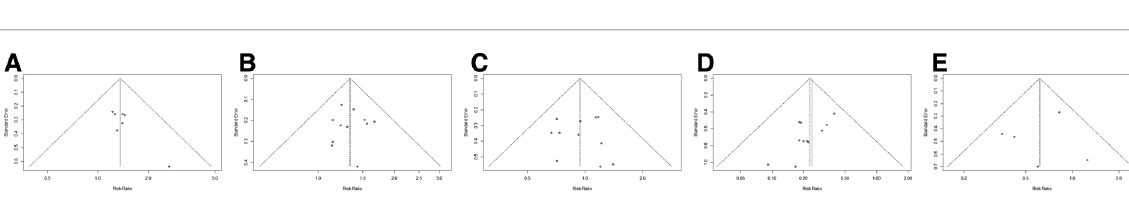
FIGURE 7 Funnel plot of treatment effect rates and adverse effects rates. ( A ) cure rate; ( B ) remarkable effect rate; ( C ) effective rate; ( D ) invalid rate; and ( E ) adverse effects rate. According to the funnel plot, there is no evidence for publication